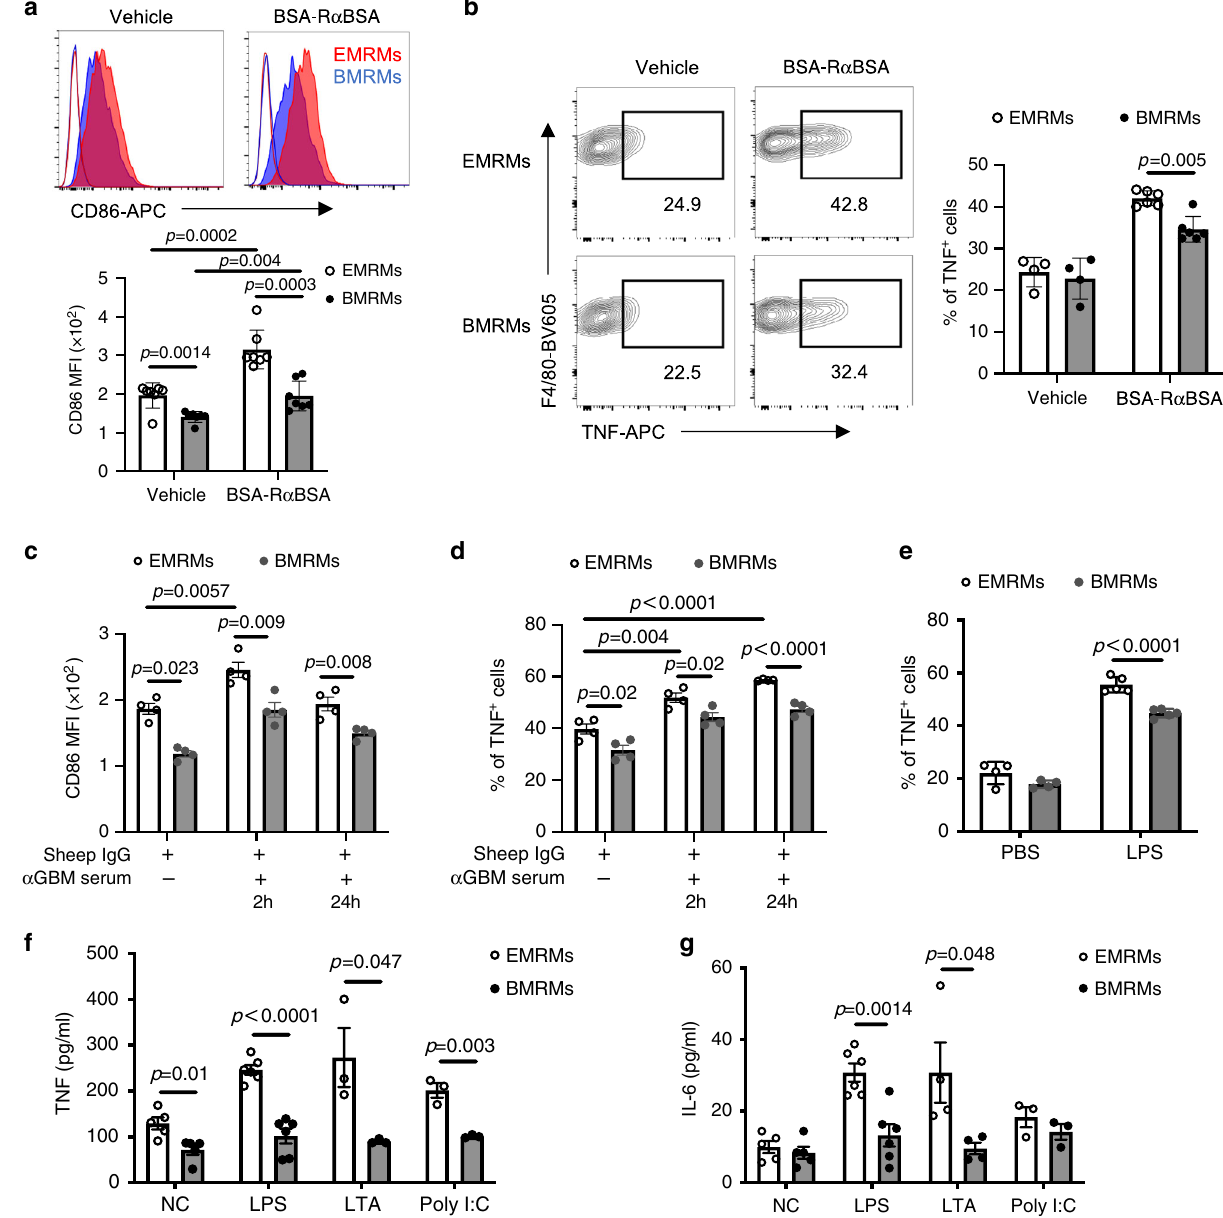
Fig. 7 EMRMs have higher immune capacity than BMRMs. EMRMs are more sensitive to immune challenges than BMRMs in vivo ( a – e ) and in vitro ( f , g ). a Representative histogram (upper panel) and MFI (lower panel) of CD86 expression on hCD59 + EMRMs and hCD59 − BMRMs 2h after PBS (Vehicle) or BSA-R α BSA injection. ( n = 7 mice per group). b The percentage of TNF positive staining in EMRMs and BMRMs 2h after PBS (Vehicle) or BSA-R α BSA injection. Left panel is representative dot plots. Right panel is the percentage of TNF + cells ( n = 4 mice for vehicle group; n = 6 mice for BSA-R α BSA group). c MFI of CD86 expression and d TNF staining in EMRMs and BMRMs 2h and 24h after α GBM serum injection in sheep IgG-preimmunized female mice. Data are pooled from two independent experiments ( n = 4 mice per time point per group). e TNF staining in EMRMs and BMRMs 3h after PBS or 5 µ g/g b.w. LPS injection in male mice. Data are pooled from two independent experiments. ( n = 4 mice for PBS group; n = 5 for LPS group). f TNF and g IL-6 level in the supernatant of sorted EMRMs and BMRMs treated with medium (NC), 100ng/ml LPS, 5 µ g/ml LTA, or 5 µ g/ml Poly (I:C) for 18h. Data are pooled from three independent experiments, each dot represents cells obtained from individual sorting pooled from two mice. ( n = 5 for NC; n = 6 for LPS; n = 3 for LTA and Poly (I:C)). All data are presented as mean±s.e.m. p -values by two-tailed unpaired t -test are indicated in a – g . Source data are provided as a Source Data fi